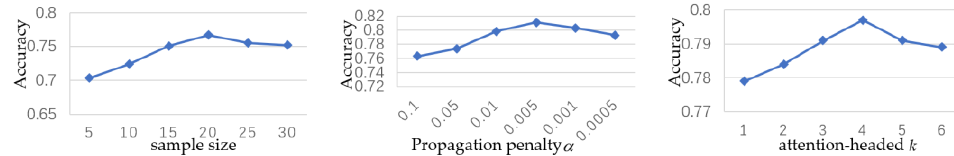
Figure 7. The accuracy of node classification in the core dataset after adjusting the hyperparameters of graph-SAGE, AP-GCN, and GAT.